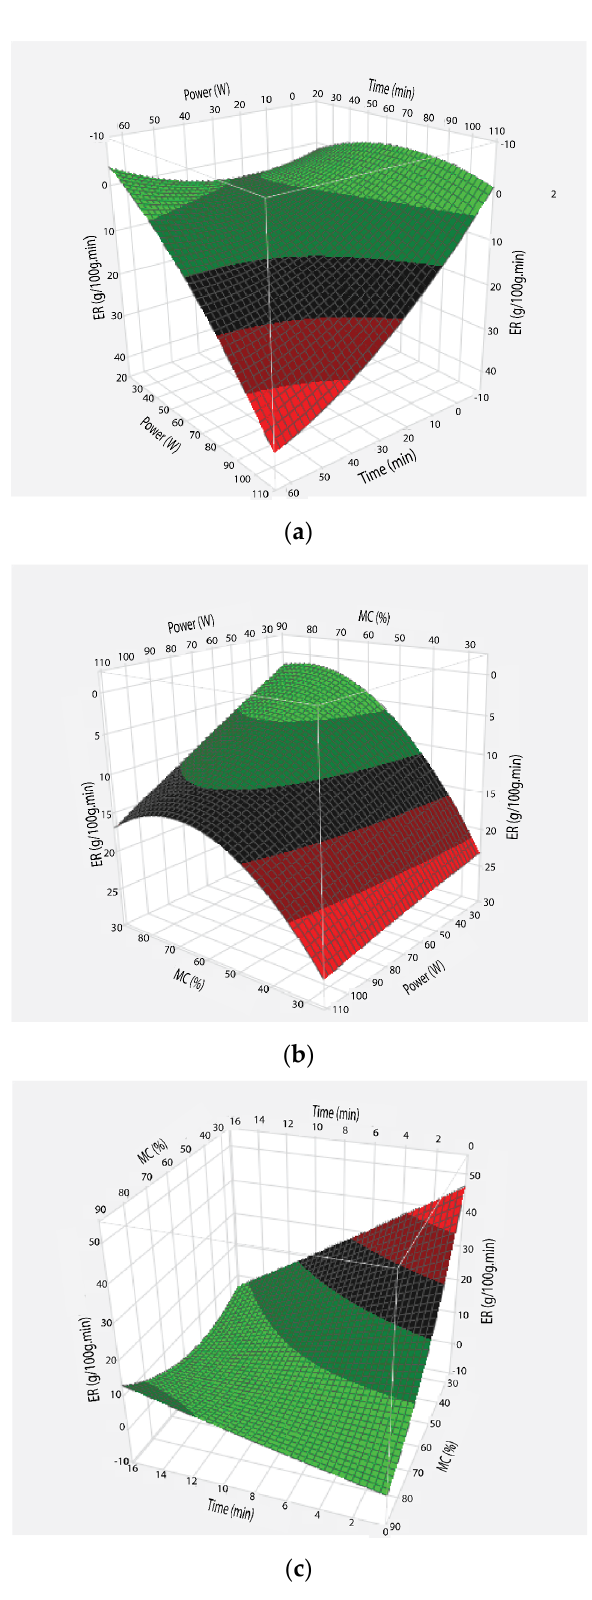
Figure 1. A graphical representation of evaporation rate influenced by the interaction of time, power and moisture contents. ( a ) Evaporation rate as a function of time and power; ( b ) Evaporation rate as a function of power and moisture content; ( c ) Evaporation rate as a function of time and moisture content.